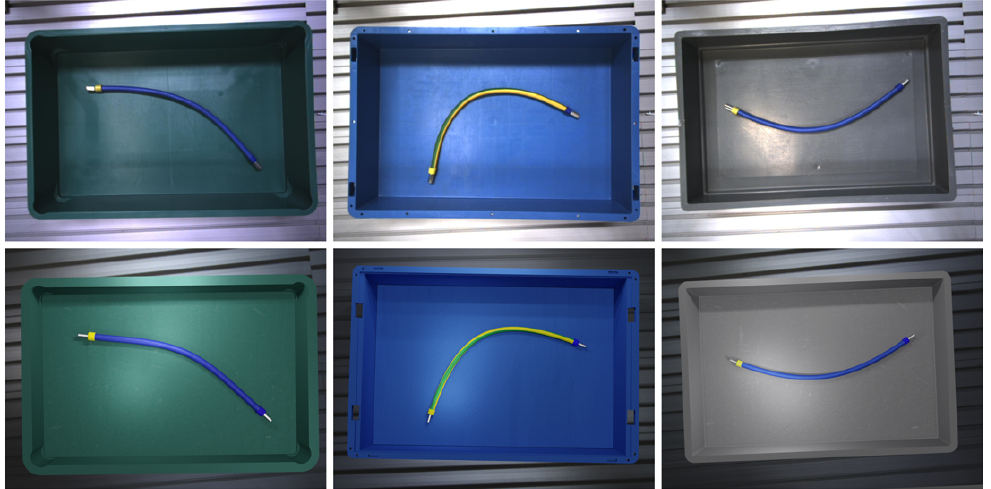
Figure 5. Exemplary comparison of real-world test images ( top row ) and synthetic training images ( bottom row ) generated by the visual replication for the scenario